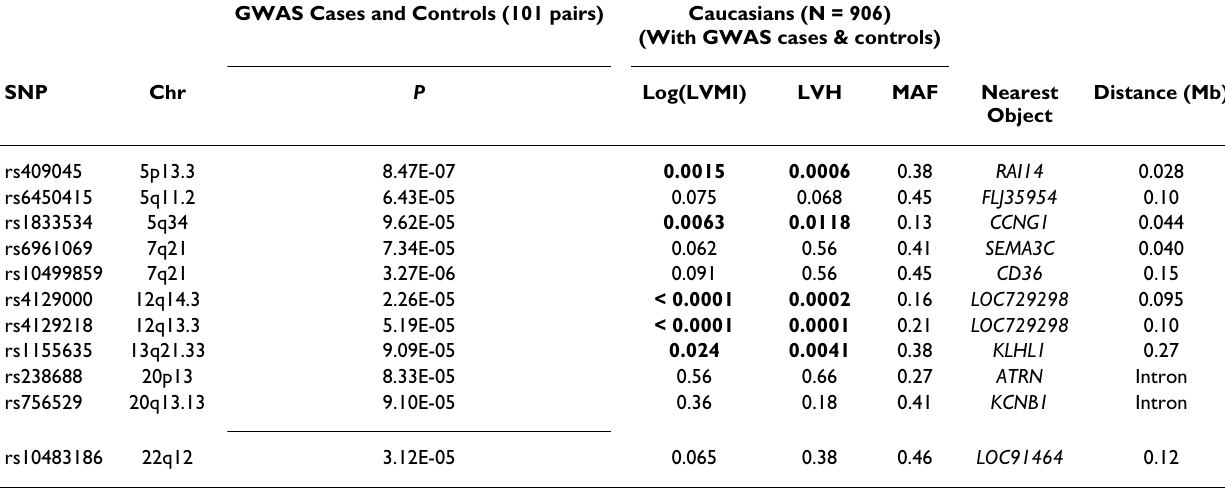
Table 4: Results (as P values) from the validation study genotyping and association analyses for the Caucasian sample, including GWAS cases and controls.* GWAS Cases and Controls (101